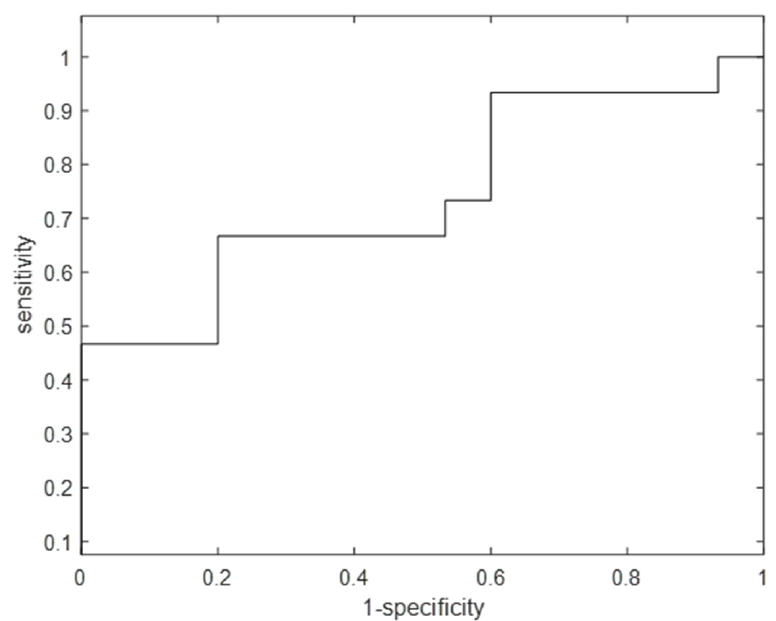
Figure 2. Receiver Operating Characteristics curve for the test set of the random forest model comparing individuals before and after ICS treatment using 20 discriminatory VOCs. The sensitivity and specificity were found to be 73% and 67%, respectively, with an area under the curve equal to 0.72. ICS: inhaled corticosteroids; VOCs: volatile organic compounds.